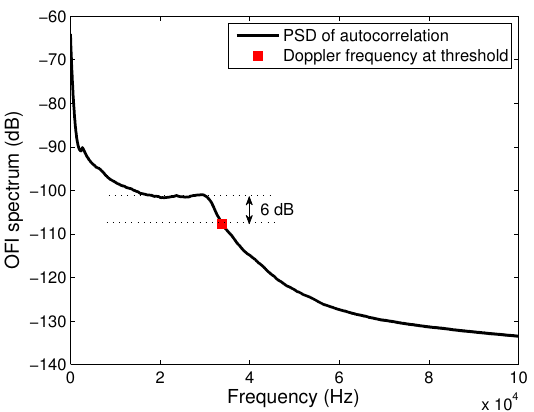
Figure 2. OFI signal spectrum for a solution of diluted milk 98% that was used for the calibration of the sensor. The maximum Doppler frequency calculated using the − 6 dB cutoff frequency method is represented by the red